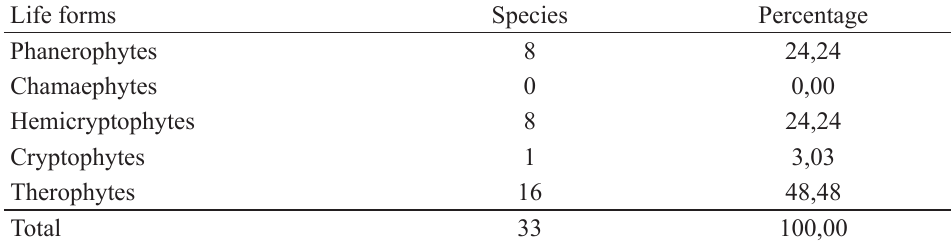
Table 7. Biological spectrum of the invasive species. Number of species and percentage are